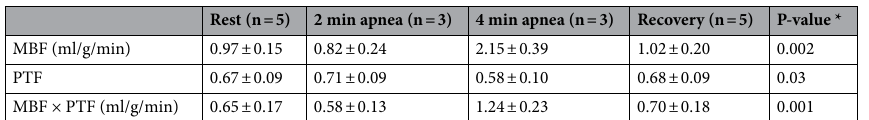
Table 4. Myocardial blood flow (MBF) as evaluated with 15 O-H 2 O-PET/CT at rest, during apnea of 378 ± 77 s and at recovery in 6 elite breath-hold divers. Values are means ± Standard deviations. *Mixed model repeated measures ANOVA. Rest compared to apnea. MBF myocardial blood flow, PTF perfusable tissue